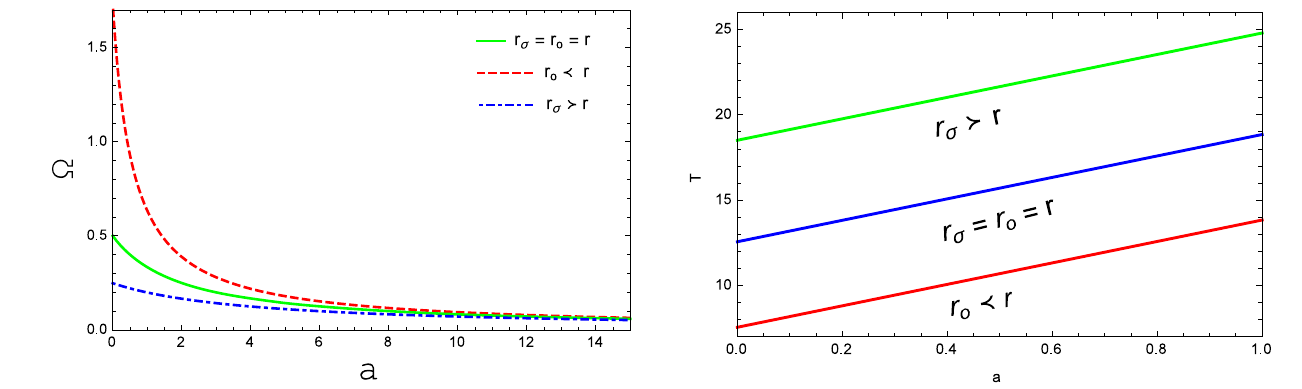
Fig. 5 The plot shows the orbital time period T versus a for different values of radius r in the range r o ≤ r ≤ r σ , where r σ and r o are the radius of time-like geodesic and null-circular geodesic, respectively. Blue color indicates for the value where the radius of time-like and null-circular geodesics are coincide, green color indicates for the value ofradiusoftime-likegeodesicandredcolorindicatesthevalueofradius of null-circular geodesic. We use units such that M = 1 , c =